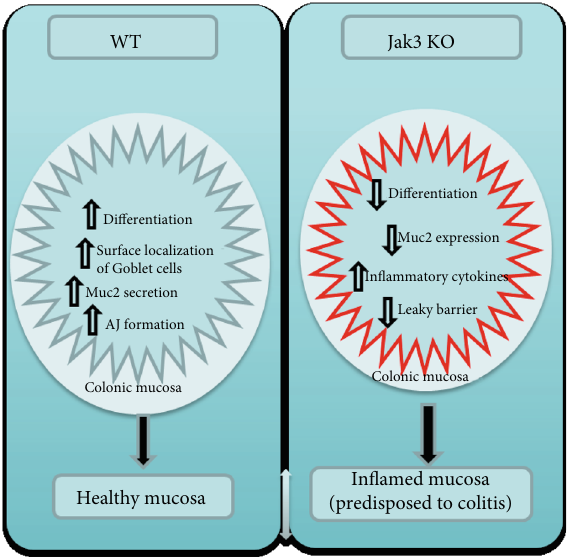
Figure 4: Proposed model for the role of Jak3 in colonic mucosal health and predisposition to colitis